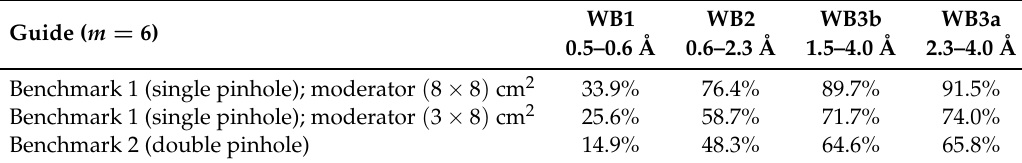
Table 1. The wavelength integrated BT ( λ ) for the four wavelength bands, obtained for each of the m = 6 benchmark